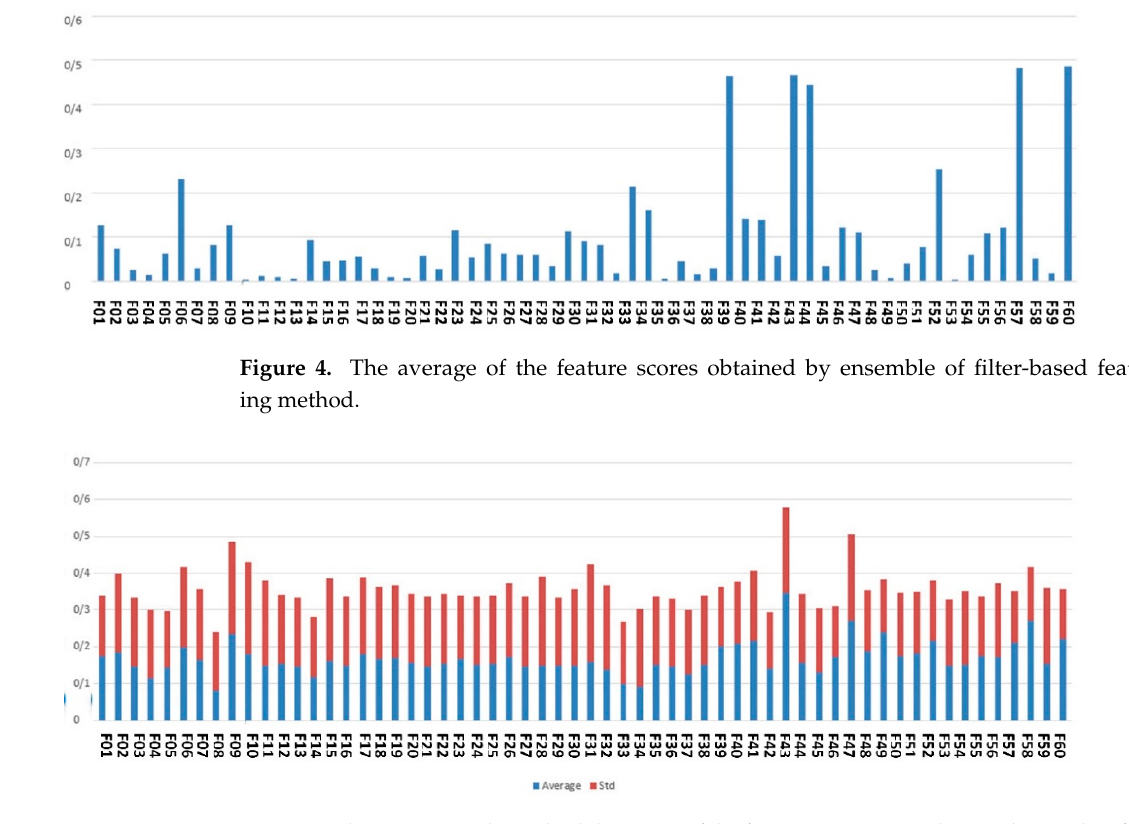
Figure 5. The average and standard deviation of the feature scores according to the results of ensemble of wrapper methods in this study for Apgar score prediction.